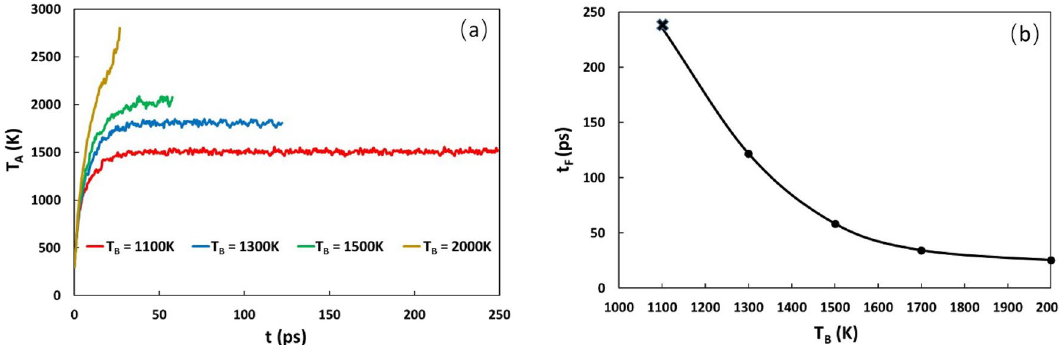
Figure 9. ( a ) The average temperature in the heating zone with the heating time at different fixed boundary temperatures. ( b ). The failure start times at different fixed boundary temperatures. Here the sample with